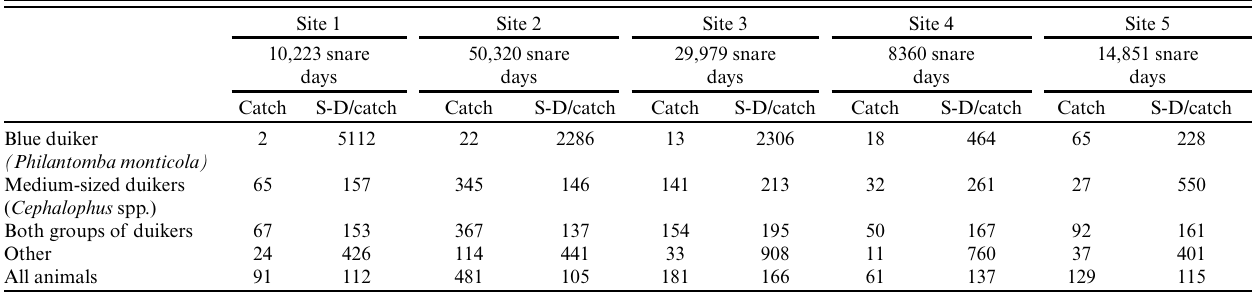
Table 3 . Single catch effort (snare days/catch) at sites